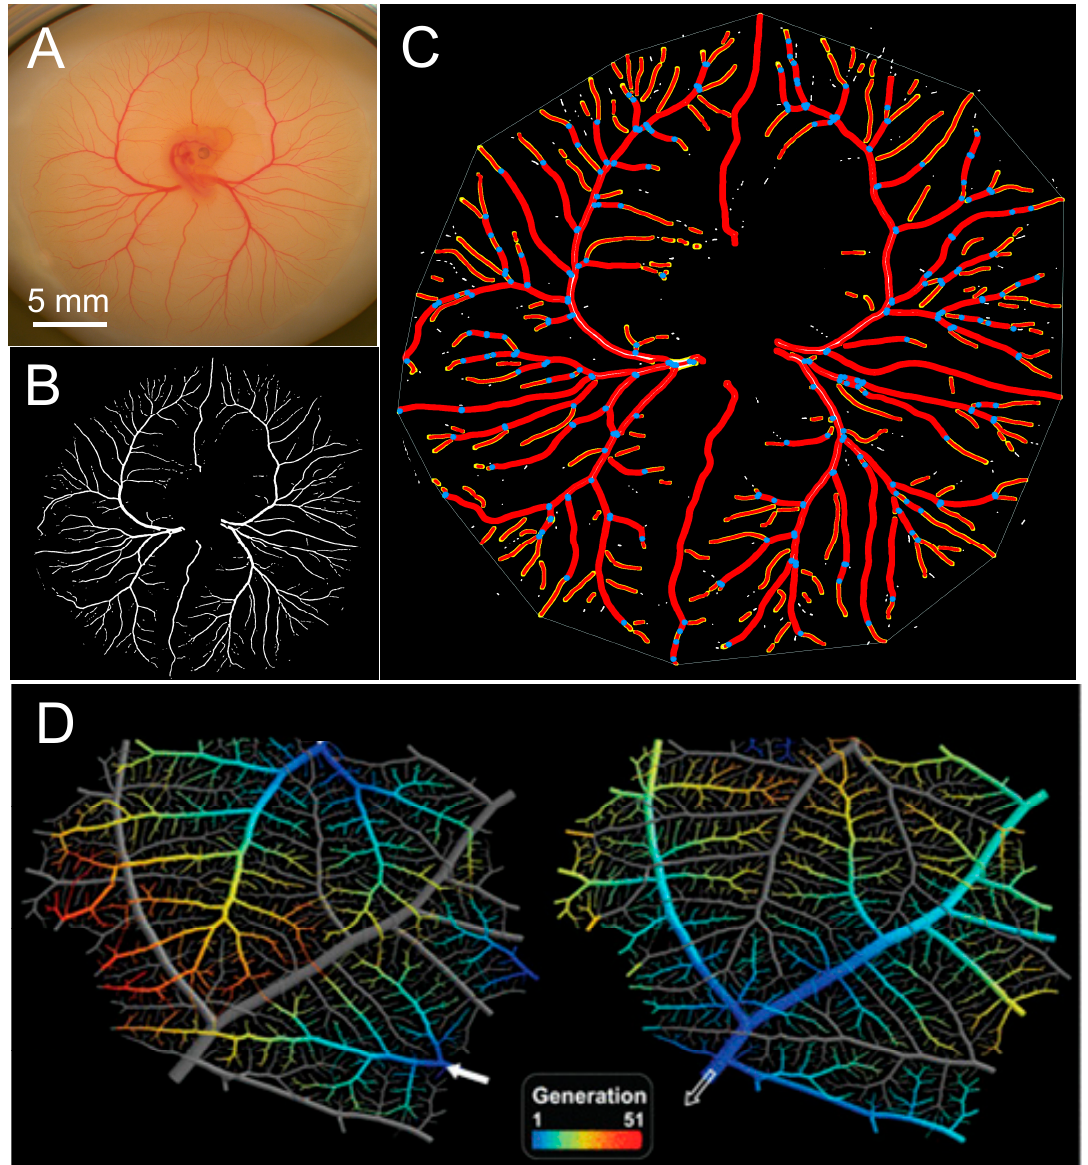
Figure 6. Computer-aided digital analysis of the length and branches of the vessels of the CAM of the 3-day-old chicken embryo. ( A ) A sample image of the CAM of a 3-day-old embryo grown ex ovo. ( B ) CAM vasculature evident in a digitally enhanced image. ( C ) Pathway of the CAM vessels (red lines) and branch points (blue dots). Images in ( B , C ) were analyzed using the AngioTool ImageJ plugin. ( D ) Vascular tree topology reconstructed from microscopic images [60]. See text for further